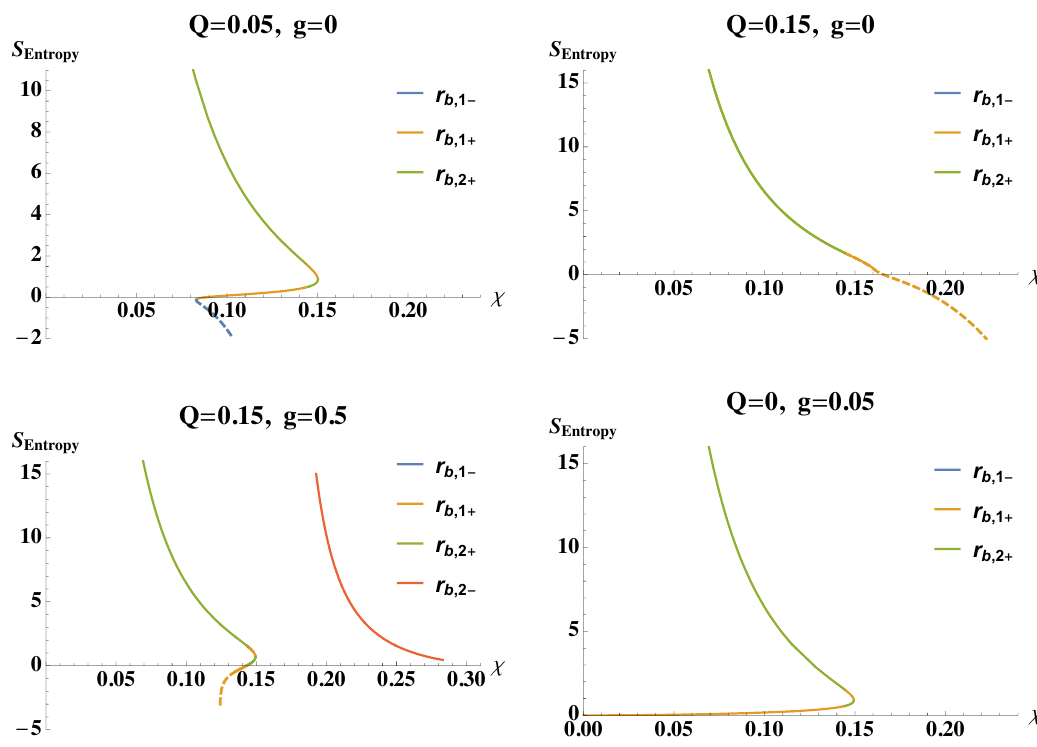
Figure 5 . Entropy (3.56) of TB-AdS for κ = 1 vs. χ for fixed values of Q and g with G = l = 1 . for fixed P and Q ,